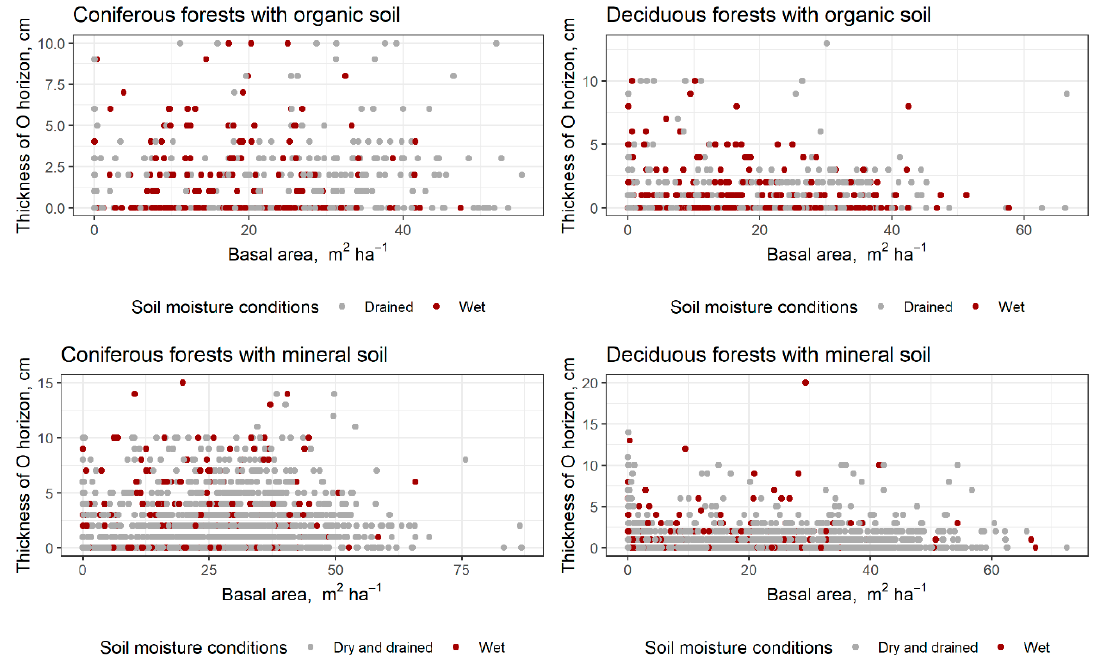
Figure 3. Distribution of thickness of the O horizon in forest land in Latvia depending on basal area. The division into groups based on soil types and moisture conditions is based on forest site types according to the national forest classifica- tion.